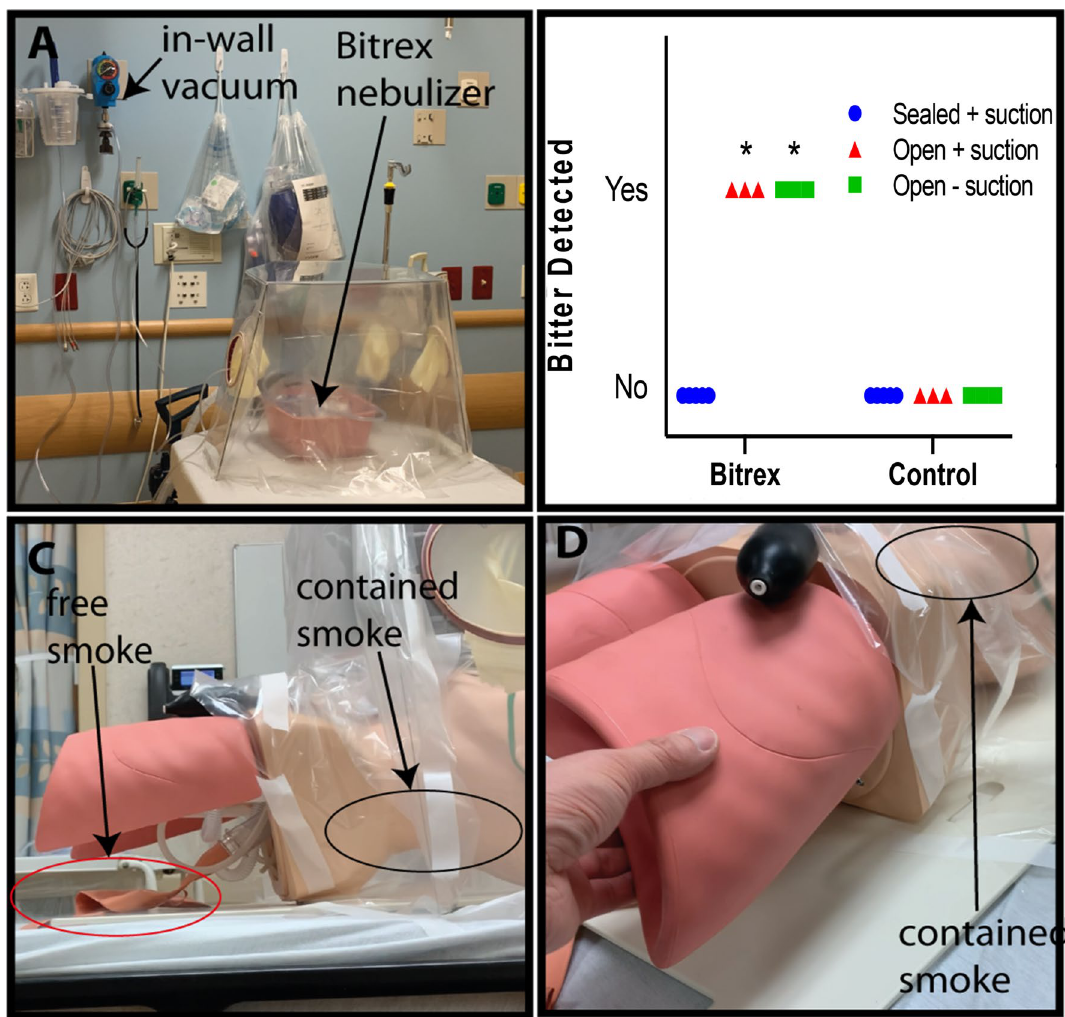
Figure 4. Screening tests of the BADGER. ( a ) Bitrex containment test setup with nebulized Bitrex or saline control inside the BADGER. Bitrex was delivered by oxygen nebulizer at 5 L/min. ( b ) Results of a double- blinded containment test. Zero out of 5 volunteers detected bitter taste when the BADGER was sealed, and suction applied at 100 mmHg to create outflow rate of 39 L/min. When the BADGER was unsealed and suction turned off, 3/3 in the Bitrex group and 0/3 in the saline group detected bitterness. With suction on but drapes open, bitterness was identified in 3/3. *p = 0.0179 compared to sealed + suction, Fishers exact test). ( c )